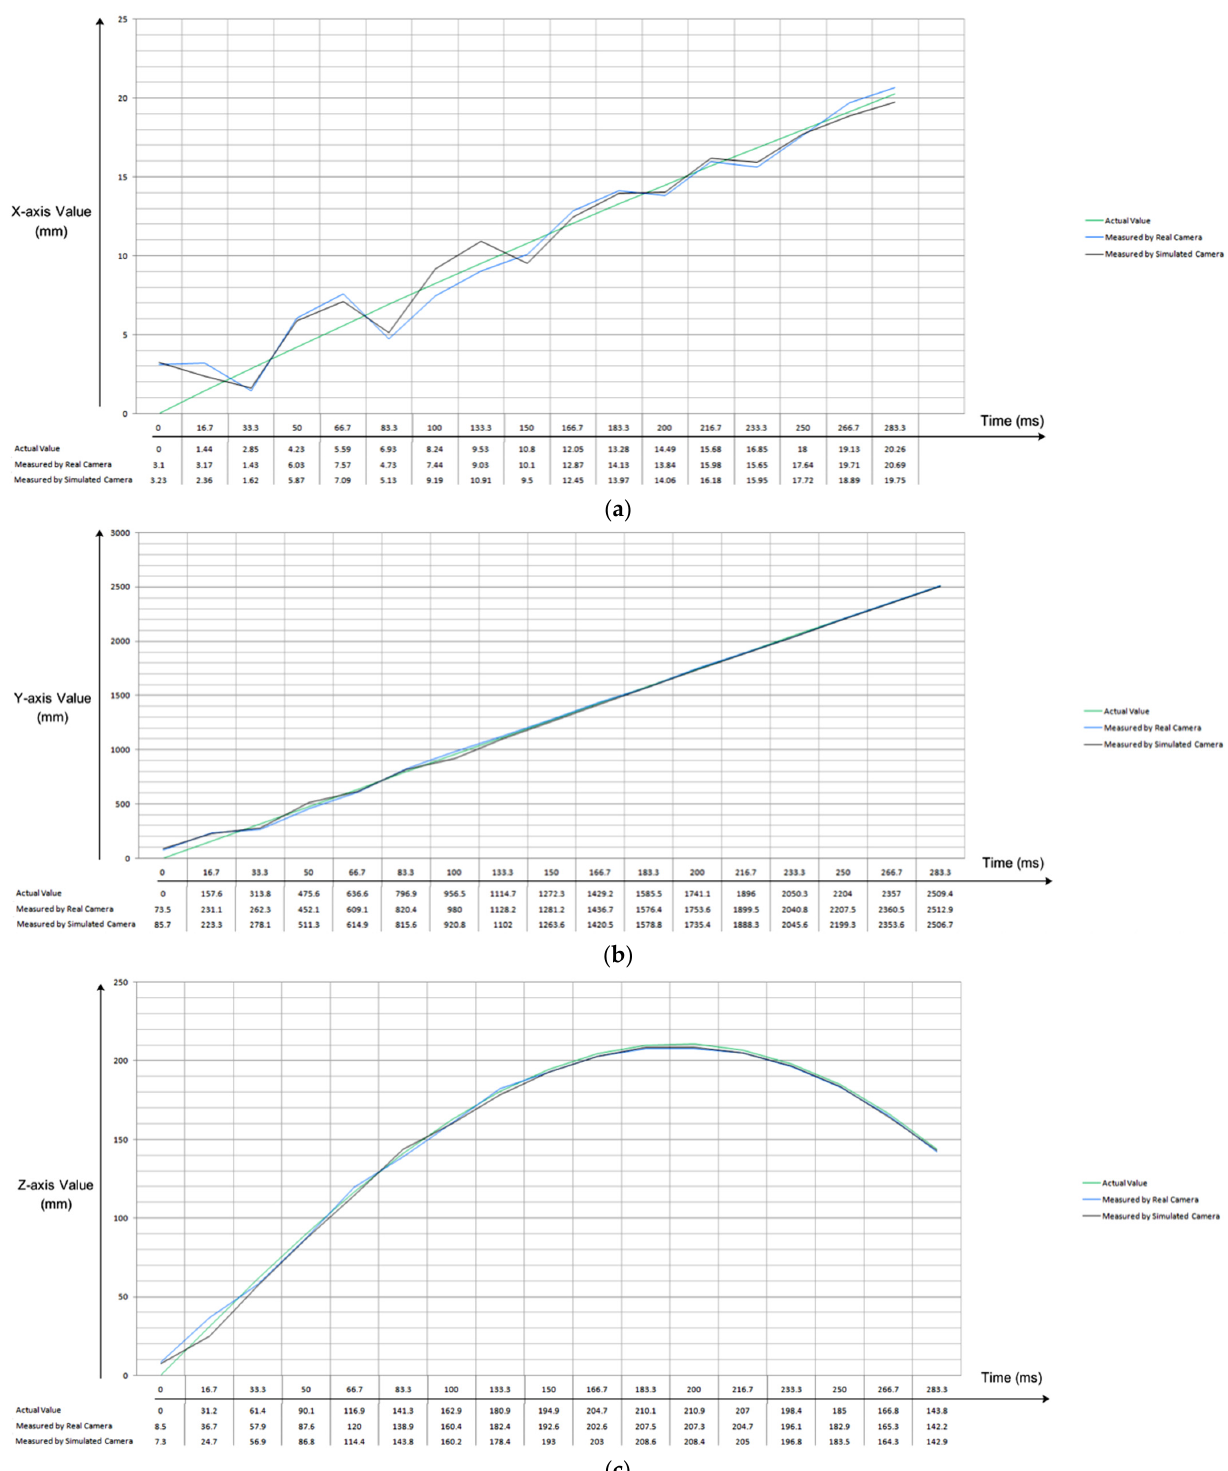
Figure 5. ( a ) Comparison of X-axis values (in actual and reconstructed trajectories by real & simu- lated camera). ( b ) Comparison of Y-axis values (in actual and reconstructed trajectories by real and simulated camera. ( c ) Comparison of Z-axis values (in actual and reconstructed trajectories by real and simulated camera).